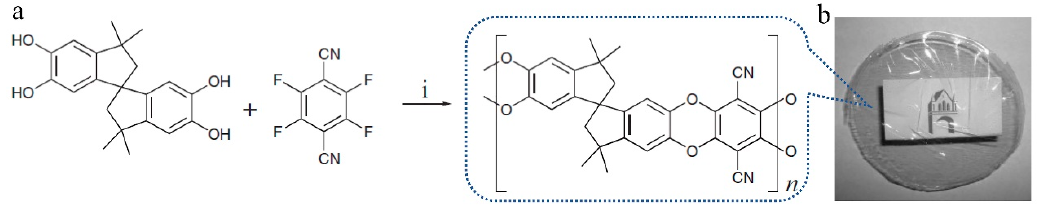
Figure 1. Synthesis of the polymer of intrinsic micro-porosity (i: reagents and conditions: K 2 CO 3 , DMF ( N , N ′ -dimethylformamide), 50–70 °C). Adapted from Reference [9].